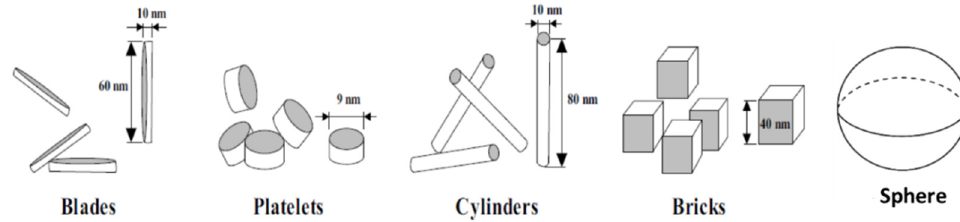
Figure 5. Nanoparticle shapes commonly used in base fluids to form nanofluids [57].